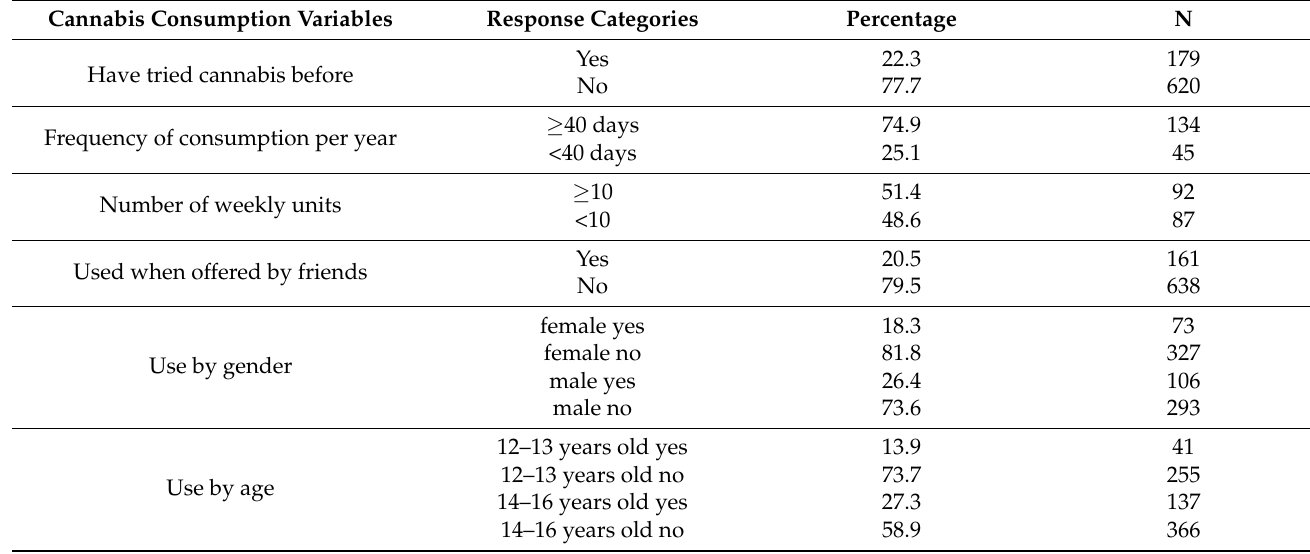
Table 1. Descriptive analysis of cannabis